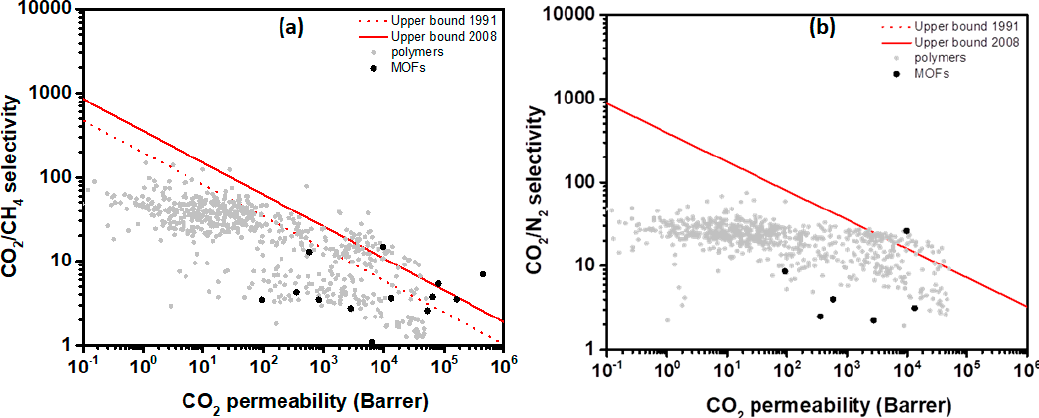
Figure 72. Comparison of permeation properties of MOFs to the performance of polymeric materials reported in the literature for membrane-based: ( a ) CO 2 /CH 4 separation ( b ) CO 2 /N 2 separation. All the data points are listed in the supporting information (Tables S3 and S4).